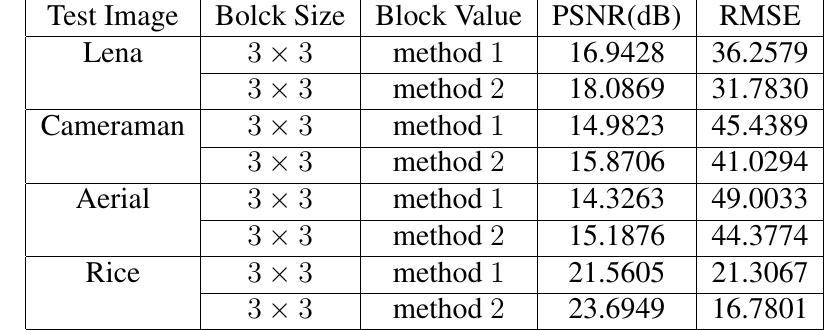
Table 2: Compression quality measures with 3 × 3 blocks using methods 1&